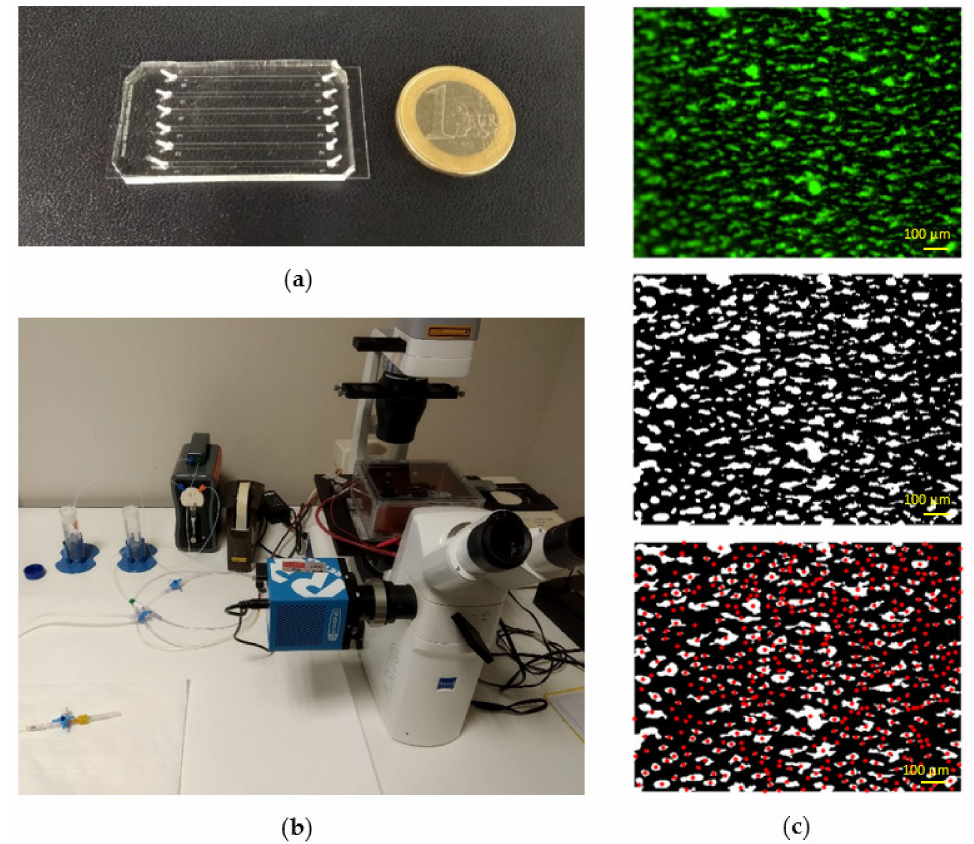
Figure 8. Photograph of the microfluidic chip ( a ) and of the experimental set-up ( b ). Results of the image-processing algorithm ( c ), from top to bottom: original image (6.3 × ), segmented binary image and identification of platelet aggregates (red dots represent individual